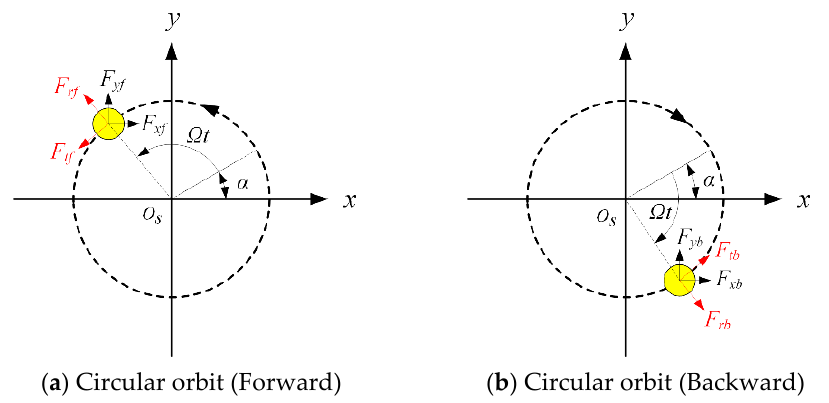
when they are in the opposite directions of the forward whirl and radial displacement, Figure 6. Coordinate transformation of fluid-induced forces. Figure 6. Coordinate transformation of fluid-induced forces. respectively.